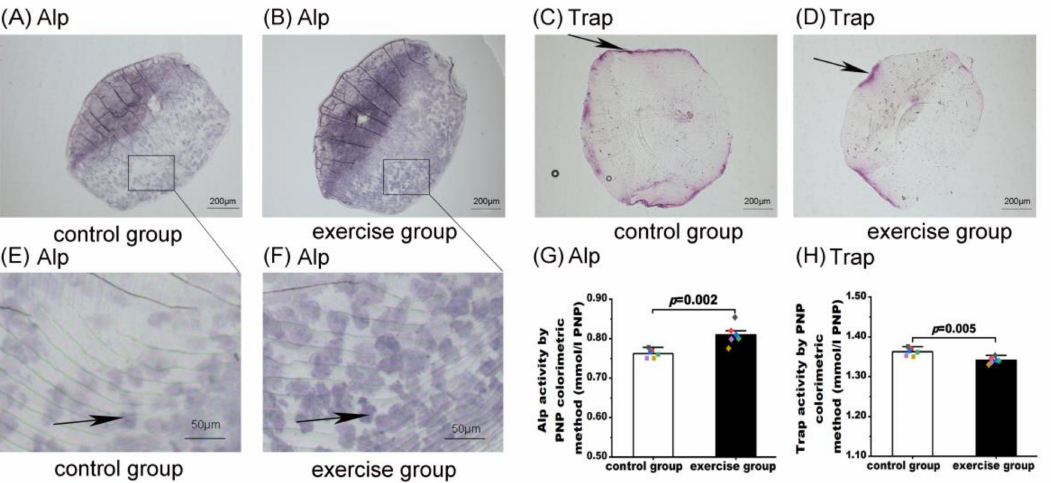
Figure 3. Measurements of alkaline phosphatase (Alp) and anti-tartrate acid phosphatase (Trap) activities in the control and exercise groups. Results of histological staining of Alp activities ( A , B